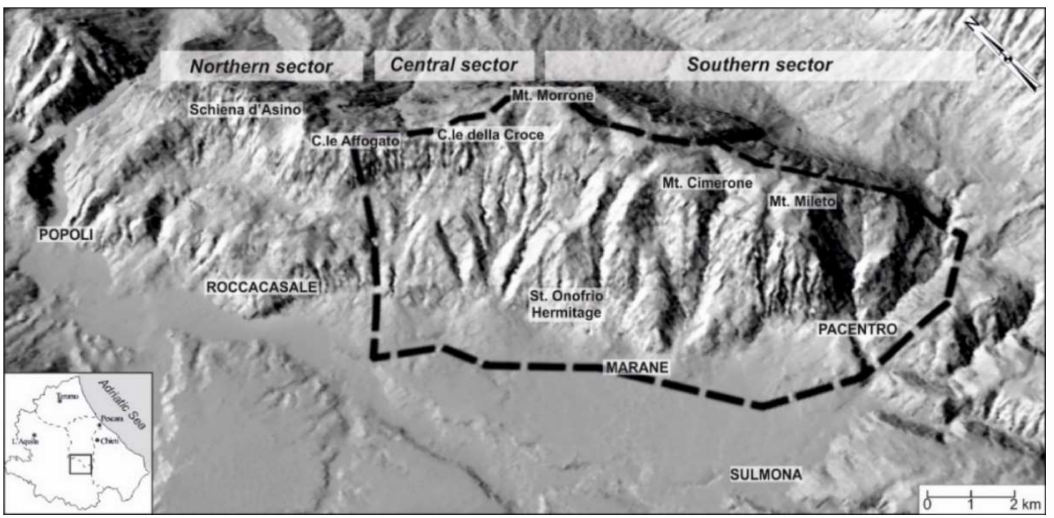
Figure 3. Shaded relief image of the Montagna del Morrone ridge. The black dashed box indicates the location of the study